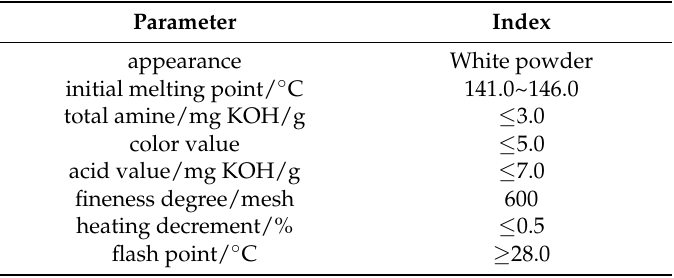
Table 3. Parameters of dispersant ethylene